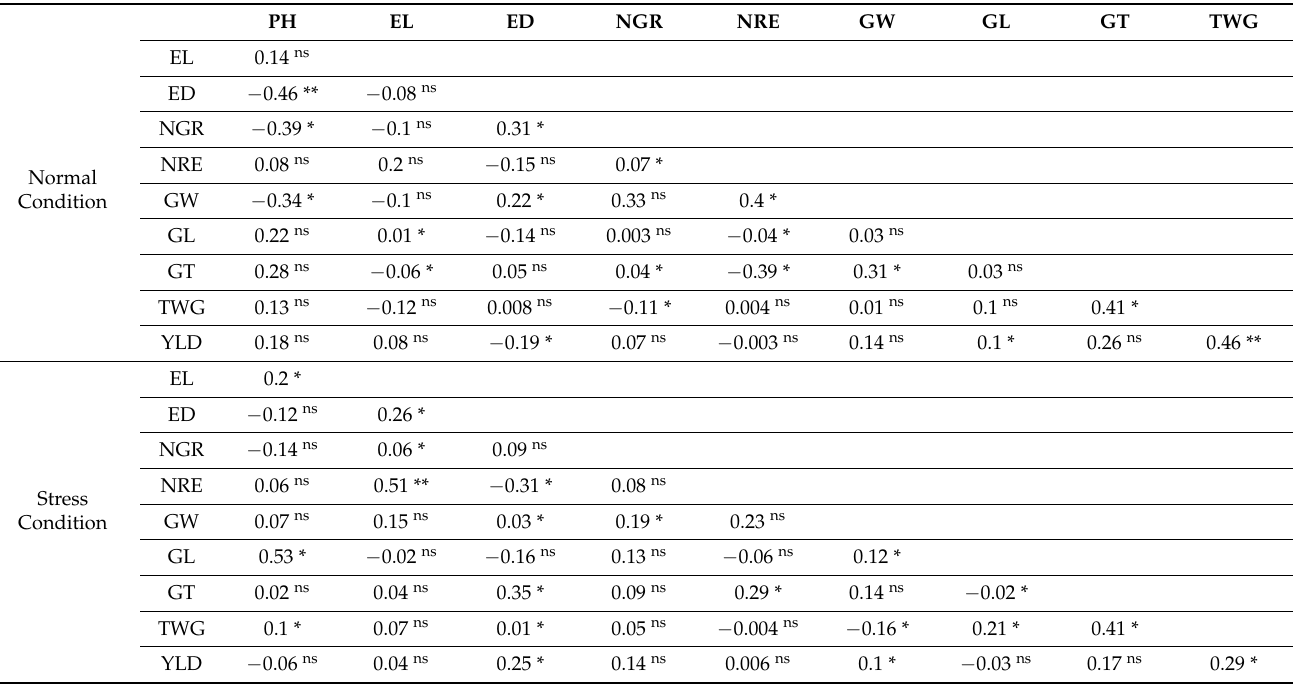
Table 3. Correlation coefficients between the evaluated traits under normal conditions and water